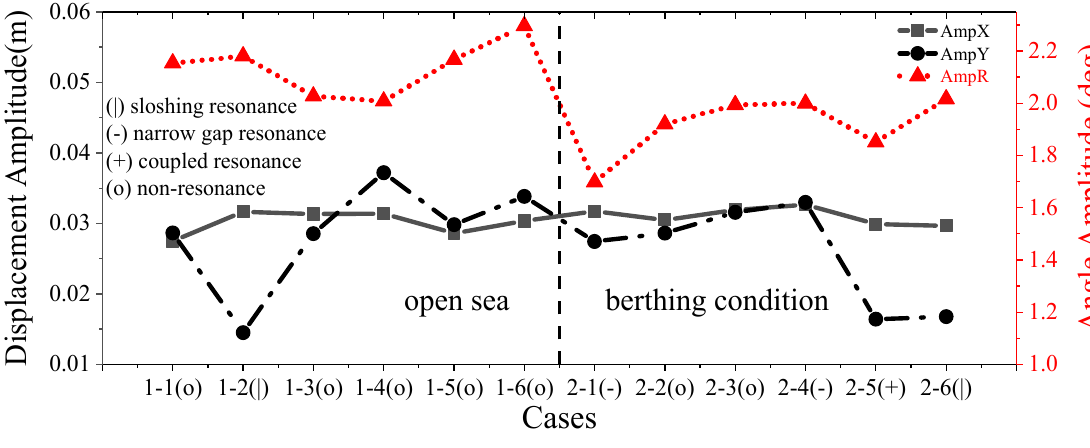
Figure 3. Motion response of floating tank under different conditions.